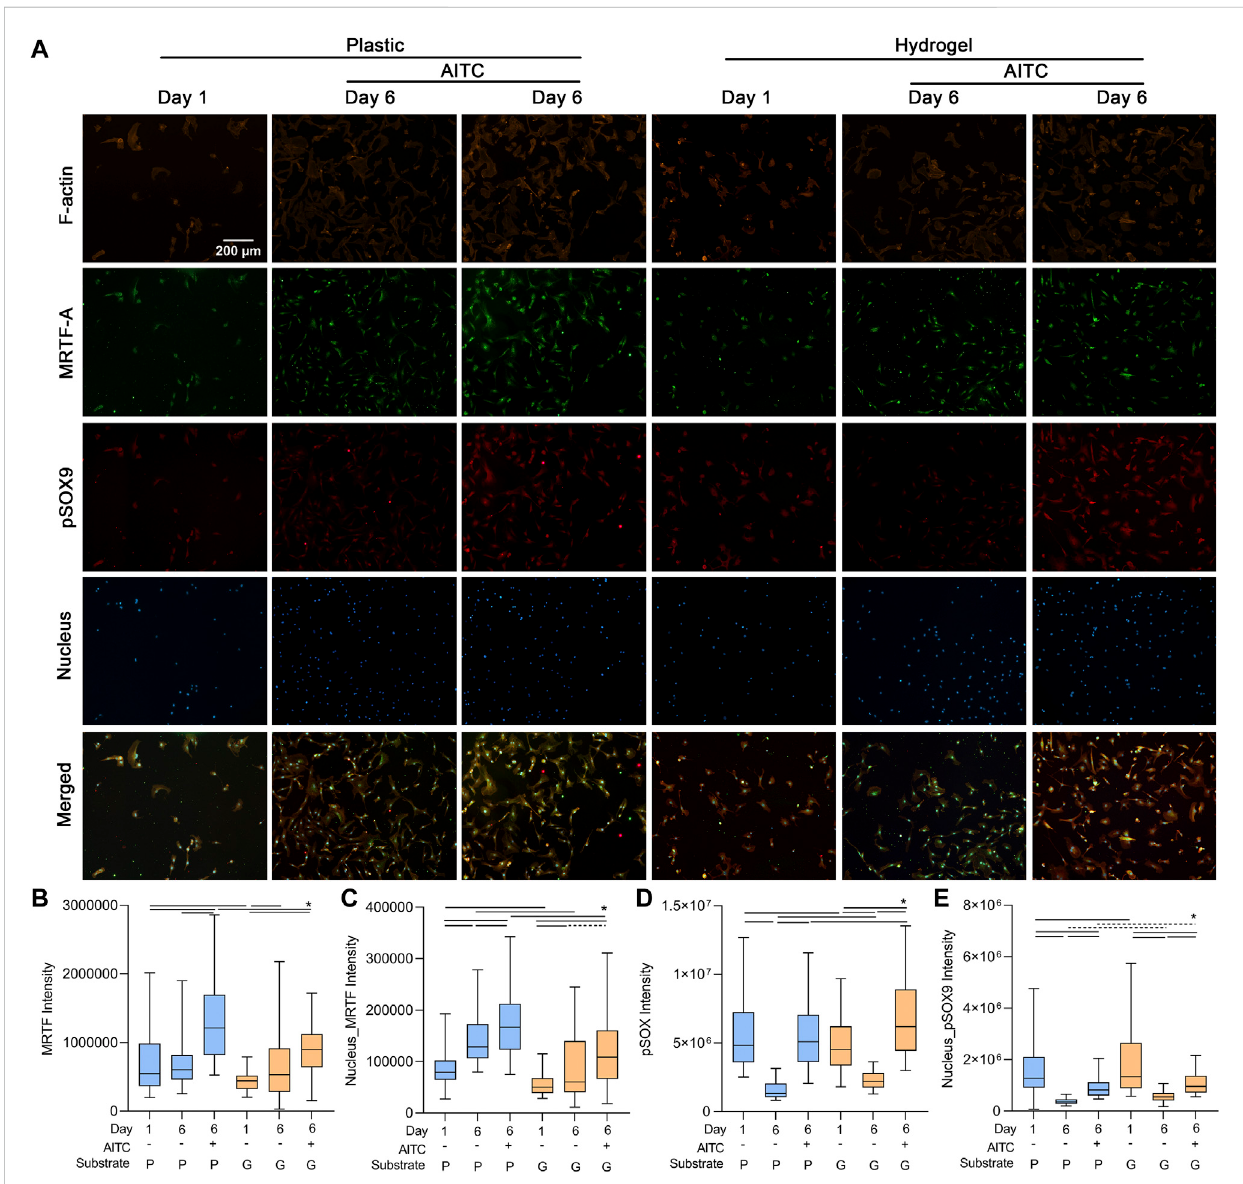
TRPA1 activation promoted pSOX9 and MRTF expression. CHs were divided into two groups: one was cultured on plastic and the other was cultured on hydrogel.Eachgroupwasthensub-groupedintothree:1-dayculture,6-dayculture,and6-dayculturewithAITCtreatment. (A) RepresentativeimagesofF-actin, MRTF-A, pSOX9, and nucleus staining of CHs, and the quantitative analysis of (B) total cellular MRTF-A, (C) nuclear MRTF-A, (D) total cellular pSOX9, and (E) nuclearpSOX9intensity.Resultsareexpressedusingtheboxplots( n =80 – 200cells).RepeatedmeasuresANOVAfollowedbyDunnett ’ spost-testwasused in the statistical analysis, and a t -test was also applied when the difference was not signi fi cant with the ANOVA test. The differences are considered statistically signi fi cant at p < 0.05. (P: plastic, G: hydrogel; line: line on the top of the boxes points to the compared objects with ANOVA, dot line: test with t